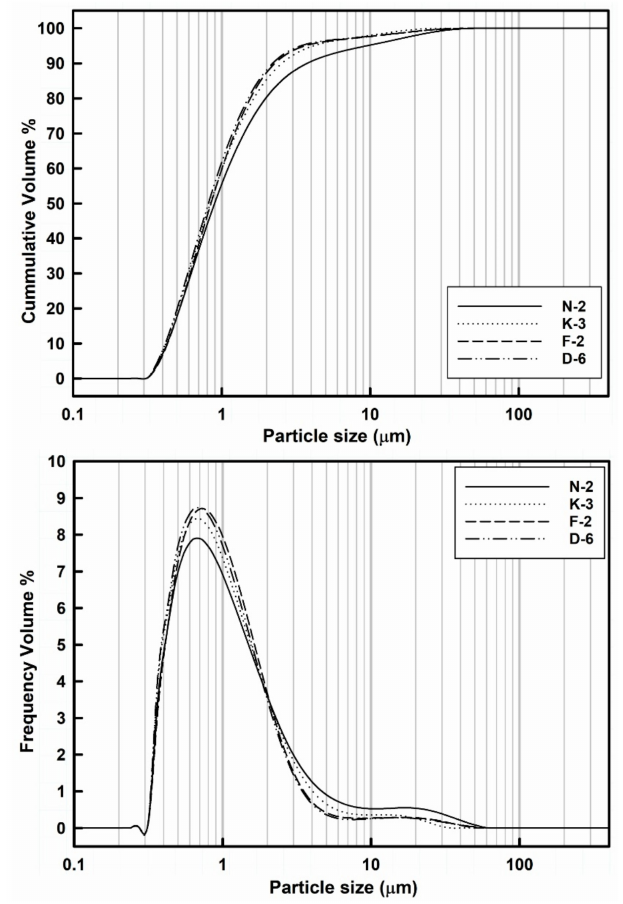
Figure 5. Laser volume-based particle size distribution frequency and cumulative curves of the studied kaolin powder